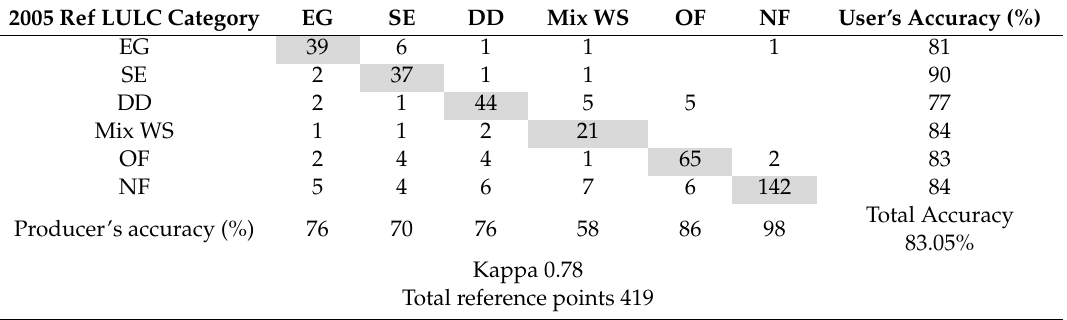
Table A10. Changes in forest cover by forest category in Siem Reap Province from 1990 to 2018.